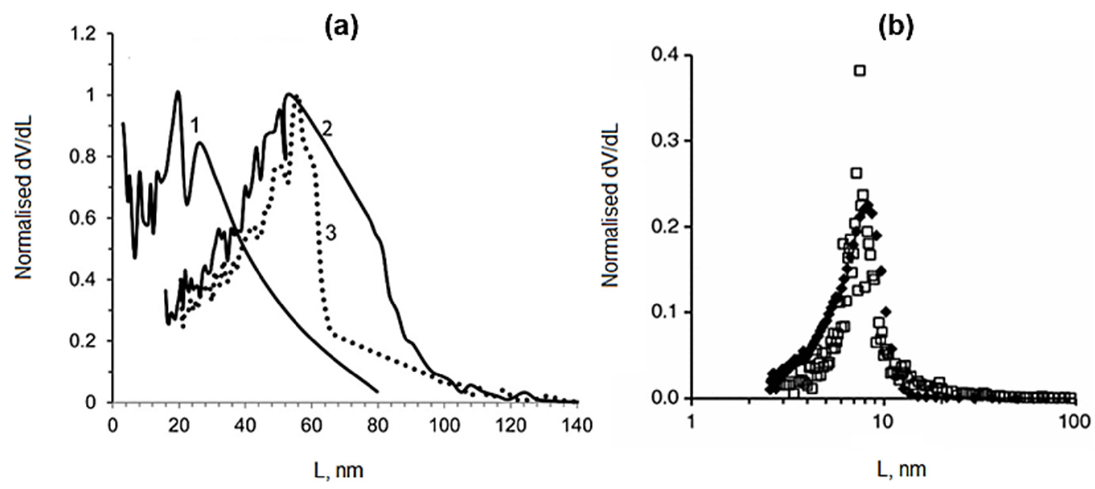
Figure 6. ( a ) Pore size distribution for aeropectins from 3 wt% citrus pectin solution (1, BJH approach; 2, Mercury porosimetry) and from 5 wt% citrus pectin solution (3, Mercury porosimetry). (reprinted from [2] with permission). ( b ) Pore size distribution from thermoporometry (filled square) and from Hg intrusion (open square) for silica gel. (reprinted from [81] with permission). Table 3 reports pore sizes of bioaerogels, determined by the mercury